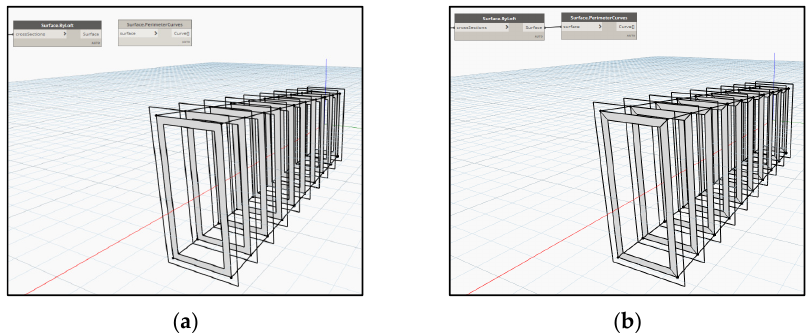
Figure 6. ( a ) Surface.ByLoft node; ( b ) Surface.PerimeterCurves node. The Family Types node allows the user to select the families of elements contained